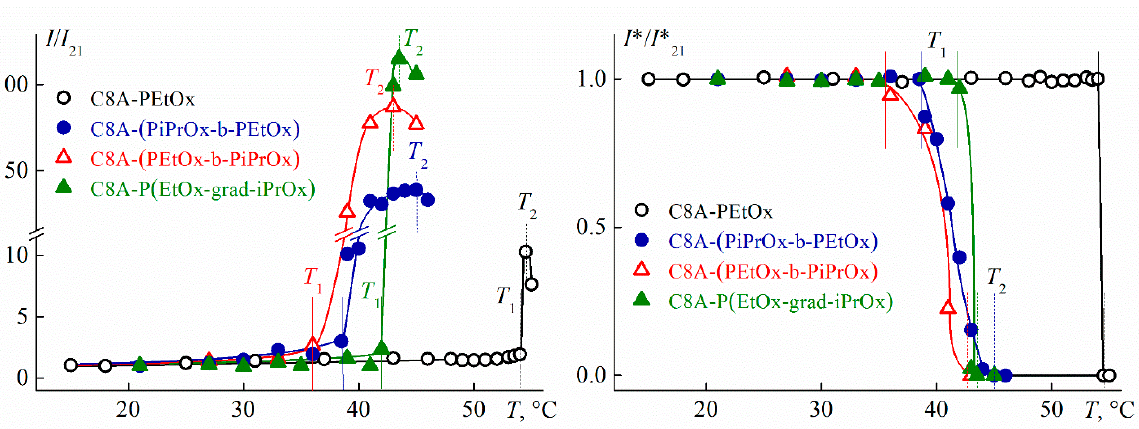
Figure 10. Dependencies of relative optical transmission I */ I * 21 and relative light scattering intensity I / I 21 on temperature T for investigated polymer stars. I * 21 and I 21 are the optical transmission and light scattering intensity at 21 °C, respectively. The concentration of the solutions is the same as in Figures 7–9.